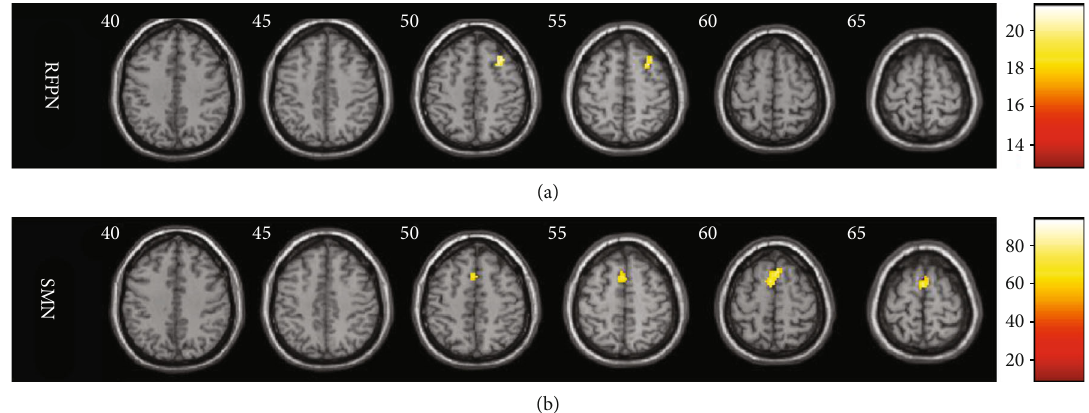
Figure 1: Aberrant functional connectivity in the RFPN and the SMN among the three groups. (a, b) Statistical maps for the RFPN and the SMN among the three groups. RFPN: right frontoparietal network; SMN: somatomotor